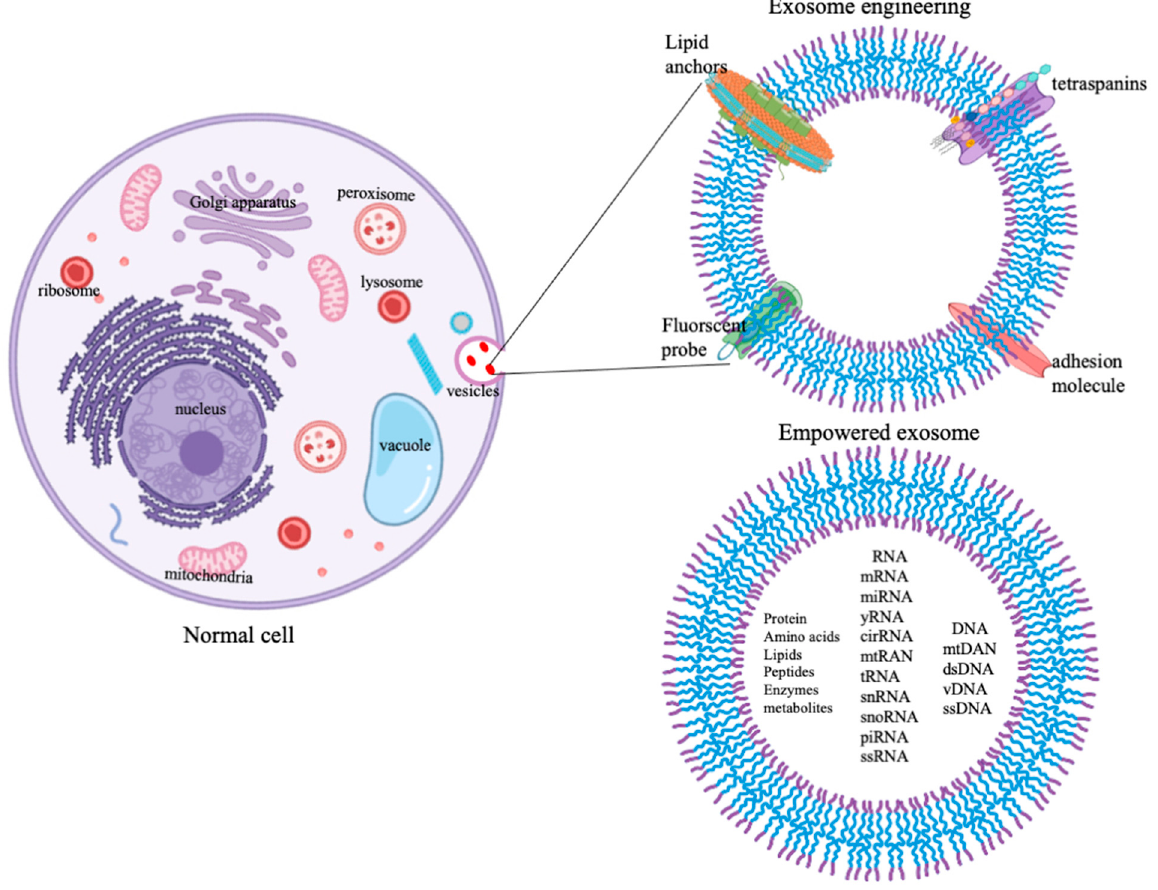
Figure 2. Schematic of exosome engineering.